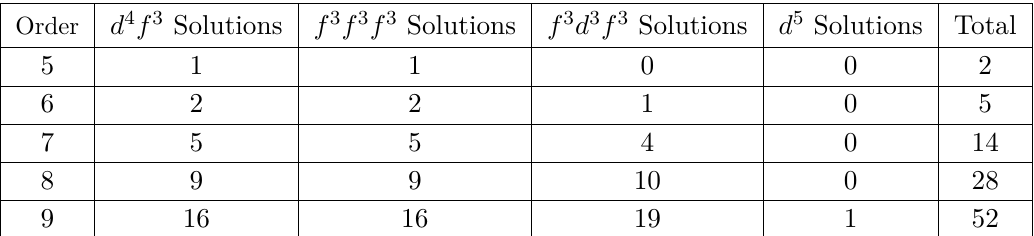
Table 6 . Doubly dual local